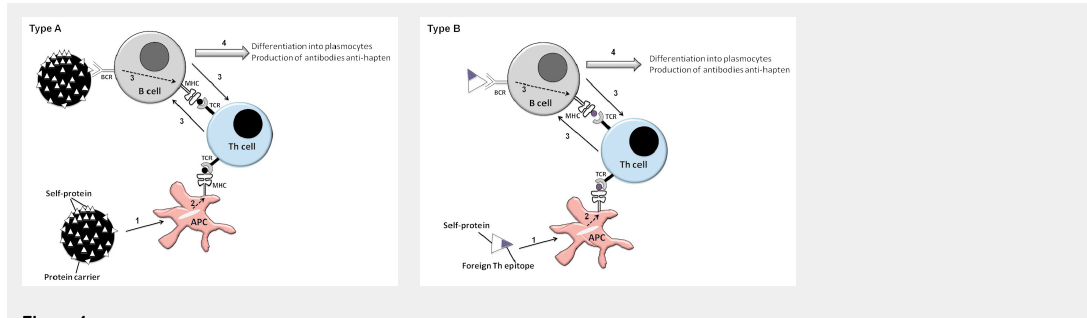
Hypothesis for the rupture of tolerance to self-antigen in strategies of type I vaccination, consisting of using a modified self-protein. Type A (Coupling of a self-protein to a carrier protein). The following steps occur subsequently: 1: The APC phagocytes the carrier protein (black circle). 2: The APC presents carrier epitopes to Th cells through their MHCII. 3: B cells specific of self-protein (small white triangles) are activated through T-B cooperation. 4: Differentiation of B cells into plasmocytes producing anti-hapten antibodies Type B (Introduction of a foreign Th epitope into the native protein of interest). The following steps occur subsequently: 1: The APC phagocytes the foreign Th epitope. 2: the APC present the foreign epitope to the Th cells. 3: B cells specific of self-protein are activated through T-B cooperation. 4: Differentiation of B cells into plasmocytes producing anti-hapten